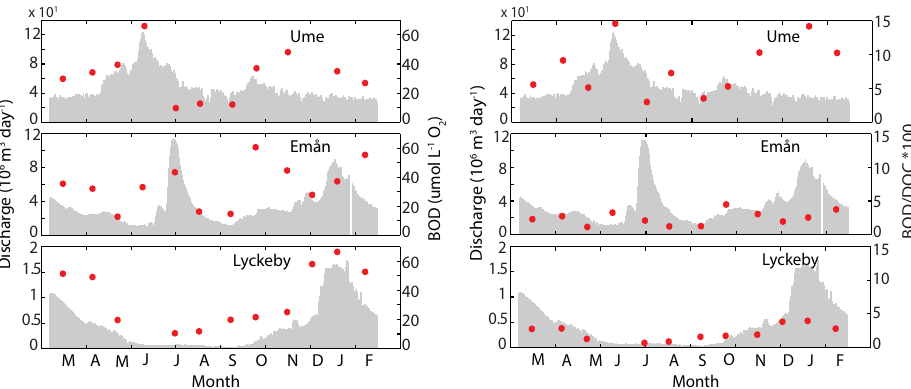
Figure 3. Biological oxygen demand (left) and percent of total dissolved organic carbon that is biologically reactive (i.e. BOD / DOC ra- Figure 3 tio · 100, assuming an respiratory quotient of one) for the three rivers. Red dots are organic matter characteristics, grey bars represent the daily flow on each river at the point of